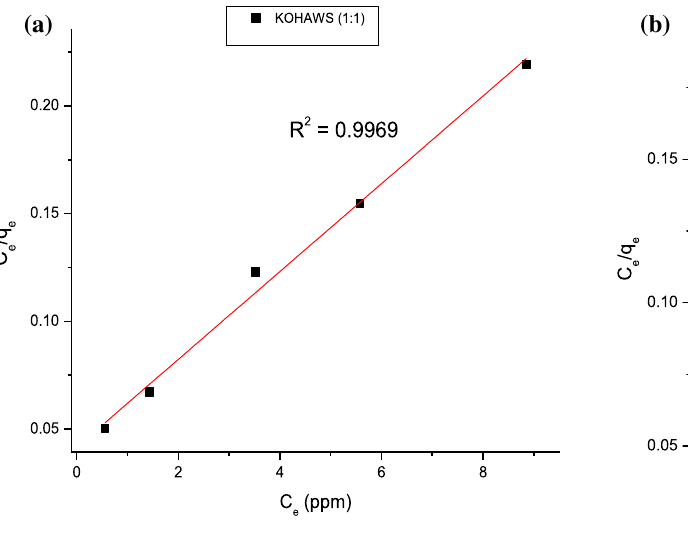
Fig. 10 Langmuir isotherm for a KOHAWS1 and b KOHAWS2